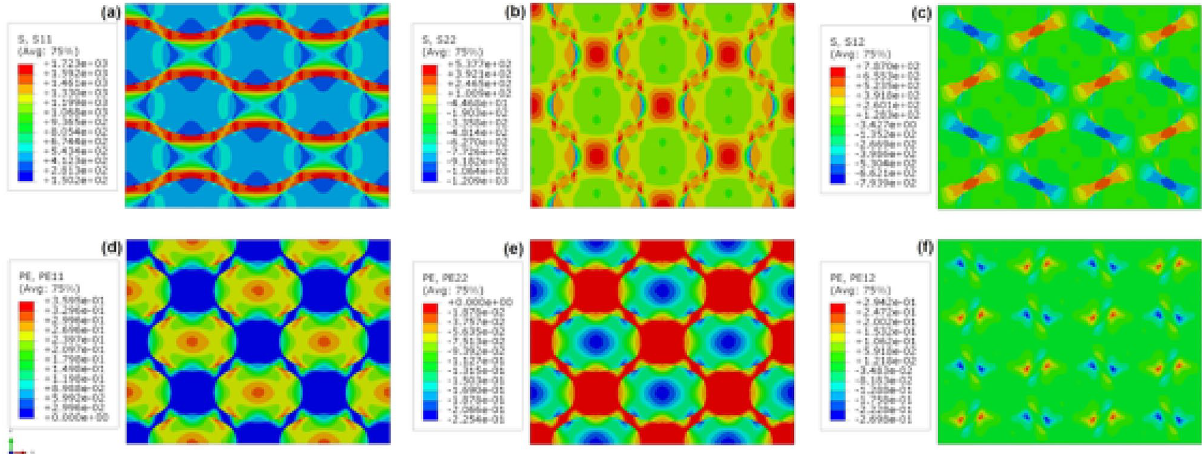
Figure 4. Distribution of normal x , y , and shear xy stresses ( a – c ) and plastic strains ( d – f ) tensor components at a global strain ε eff = 0.174 in representative cells of bHS material.